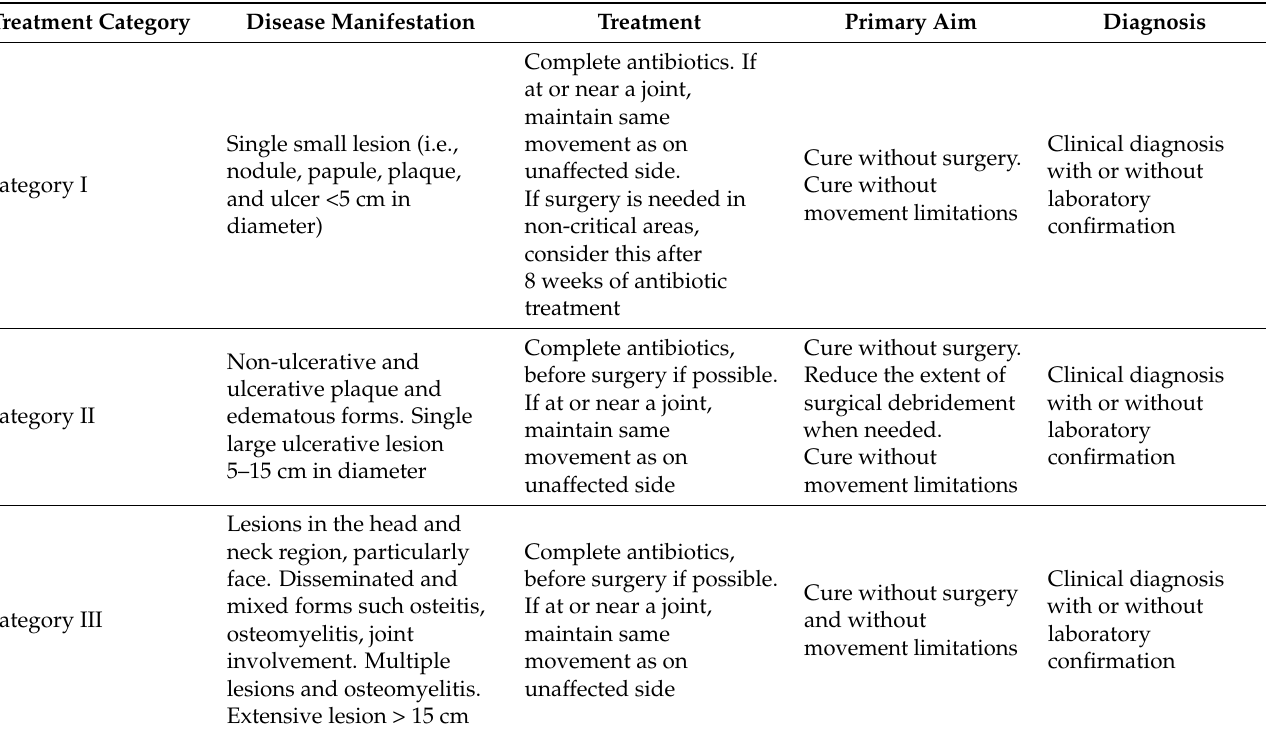
Table 1. Summary of the different categories of Buruli ulcer infections according to the WHO approach and their respective treatment guidelines and primary aim of care